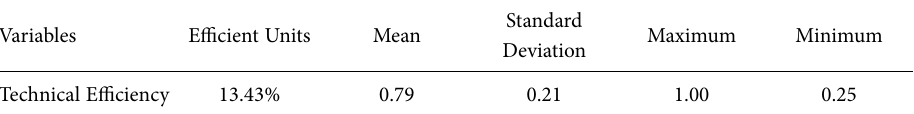
Table 3. Technical efficiency scores of citrus